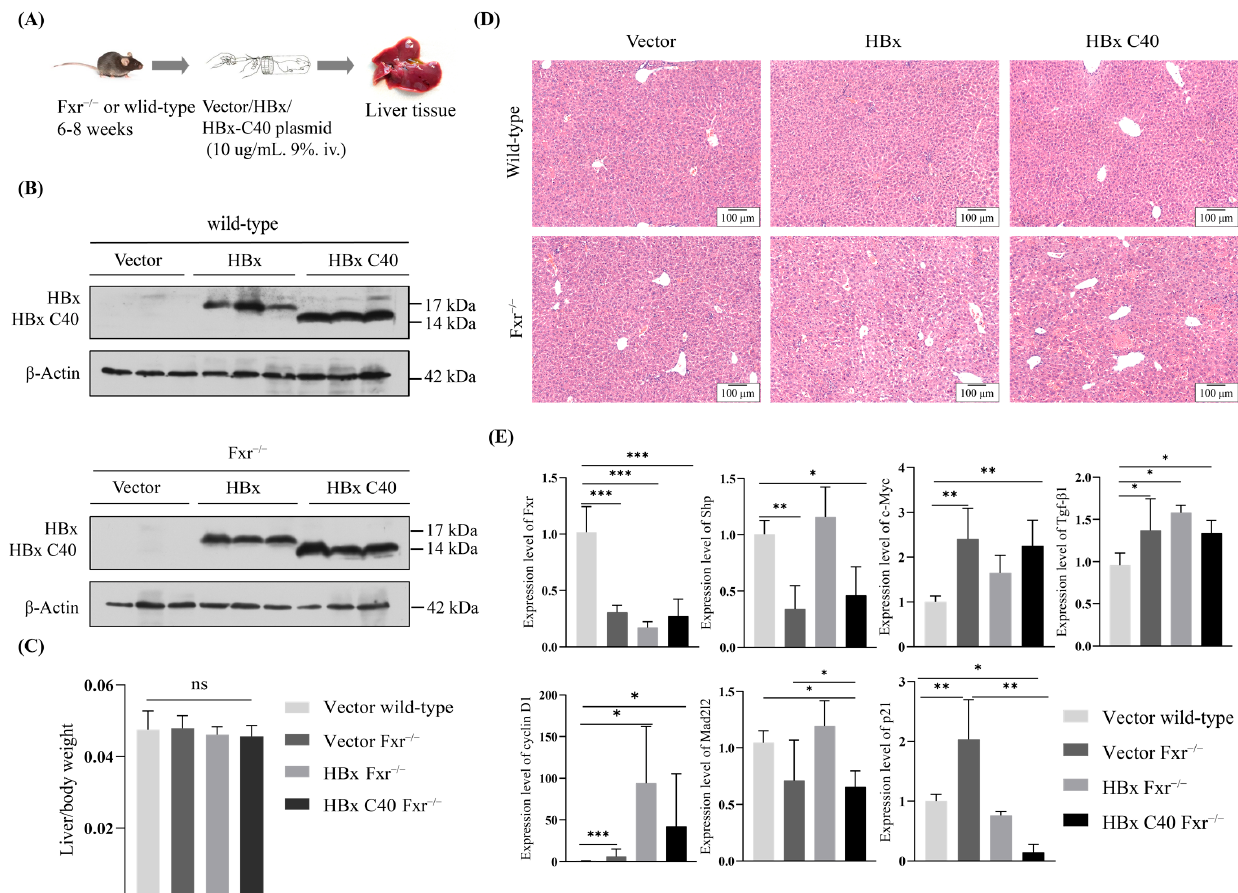
Figure 4. Effect of HBx or HBx C40 on transient mouse models. ( A ) Mouse model scheme of HBx C40 transient overexpression by hydrodynamic gene delivery. ( B ) Protein expression of HBx, and HBx C40 24 h after hydrodynamic gene delivery in wild-type or Fxr − / − mice. ( C ) Ratio of the liver to body weight. ( D ) Representative images of H&E staining of mouse liver in each group are shown. Scale bar = 100 µ m. ( E ) The mRNA expression of Fxr, Shp, c-Myc, Tgf- β 1, cyclin D1, Mad2l2, and p21. * p < 0.05, ** p < 0.01, *** p < 0.001, ns no